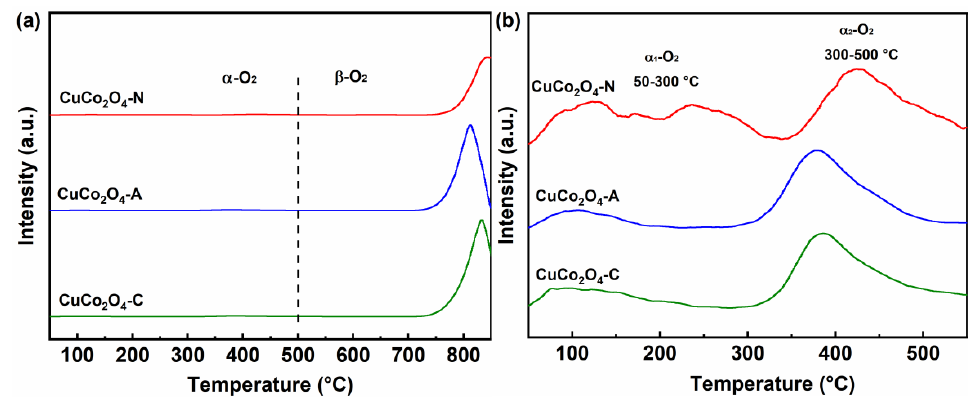
Figure 6. O 2 -TPD profiles ( a ) and the enlarged O 2 -TPD profiles in the temperature range of 50 °C to 550 °C ( b ) of the CuCo 2 O 4 - x ( x = N, A and C) catalysts.